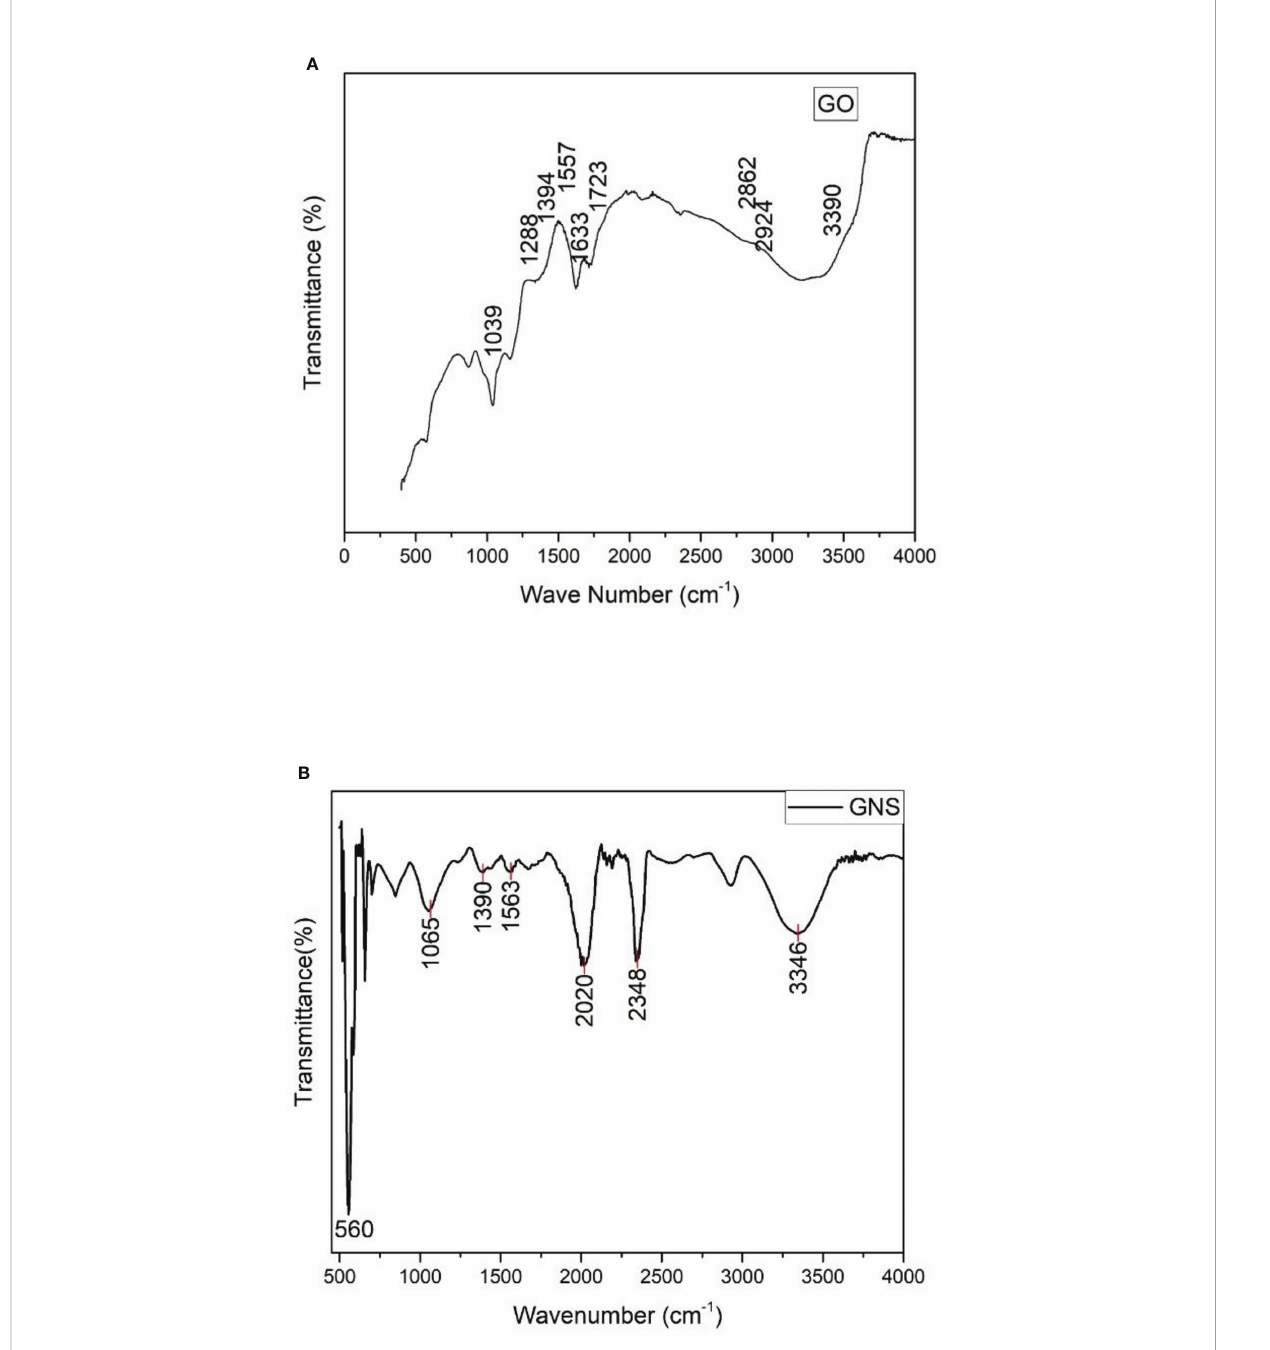
FIGURE 4 (A) = FTIR spectrum of synthesized graphene oxide; (B) = FTIR spectrum of green synthesized graphene oxide